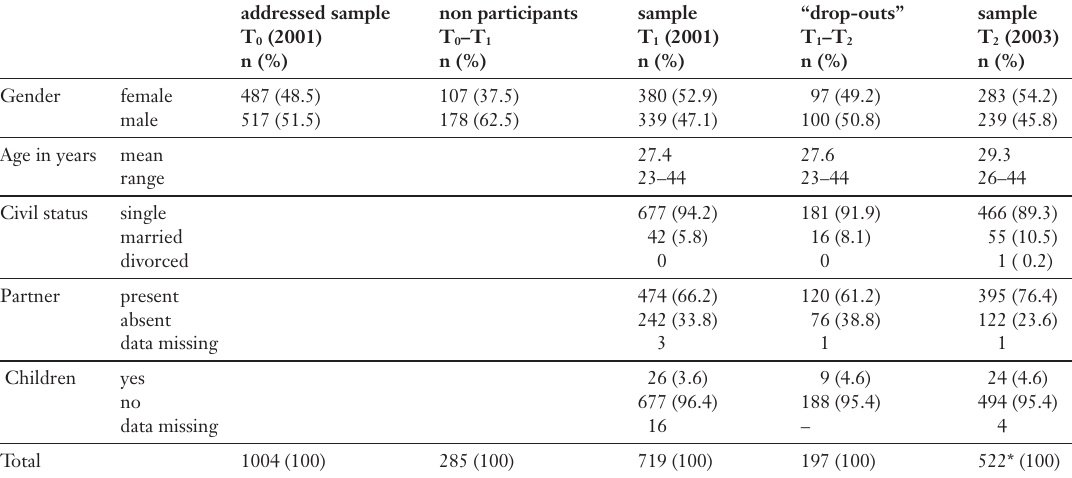
Table 1 Sample and sample development of the prospective